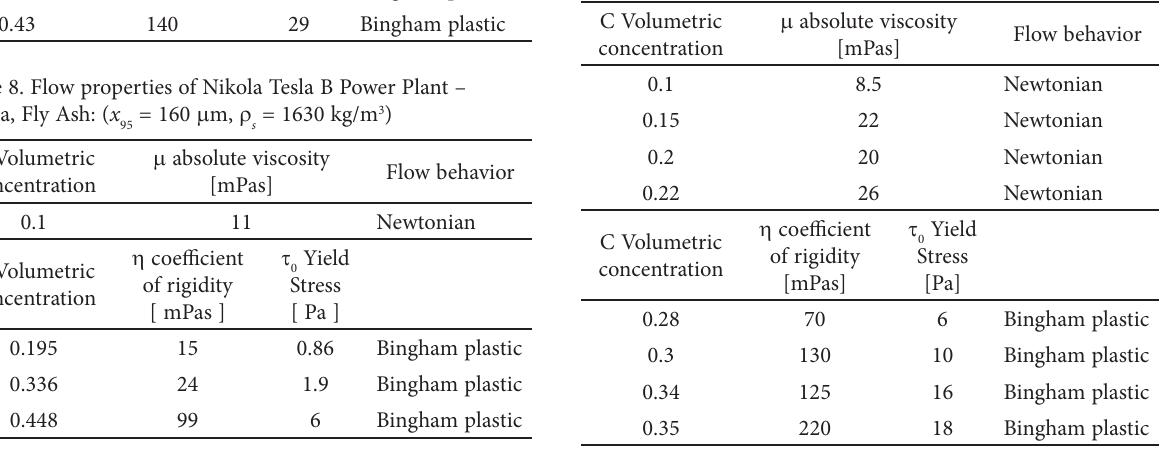
Table 10. Flow properties of Eren Pow. Plant – Turkey, Fly